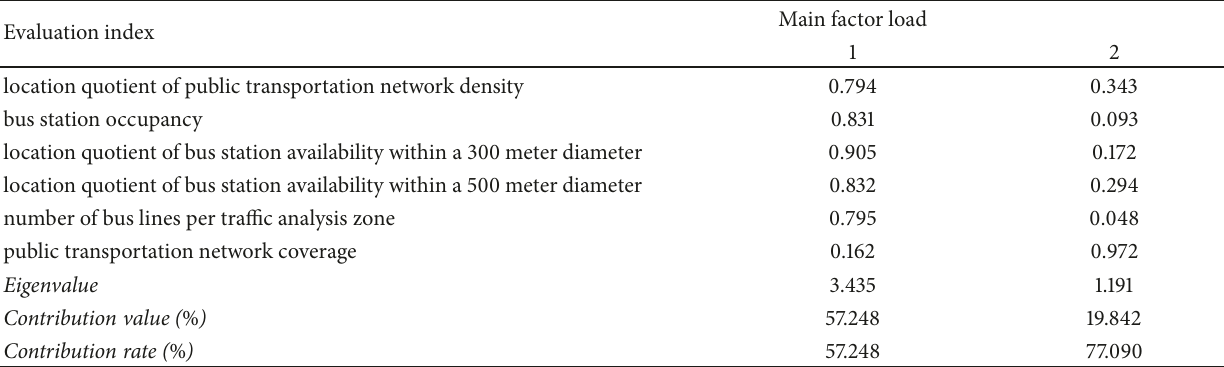
Table 2: Calculation results of main spatial deprivation